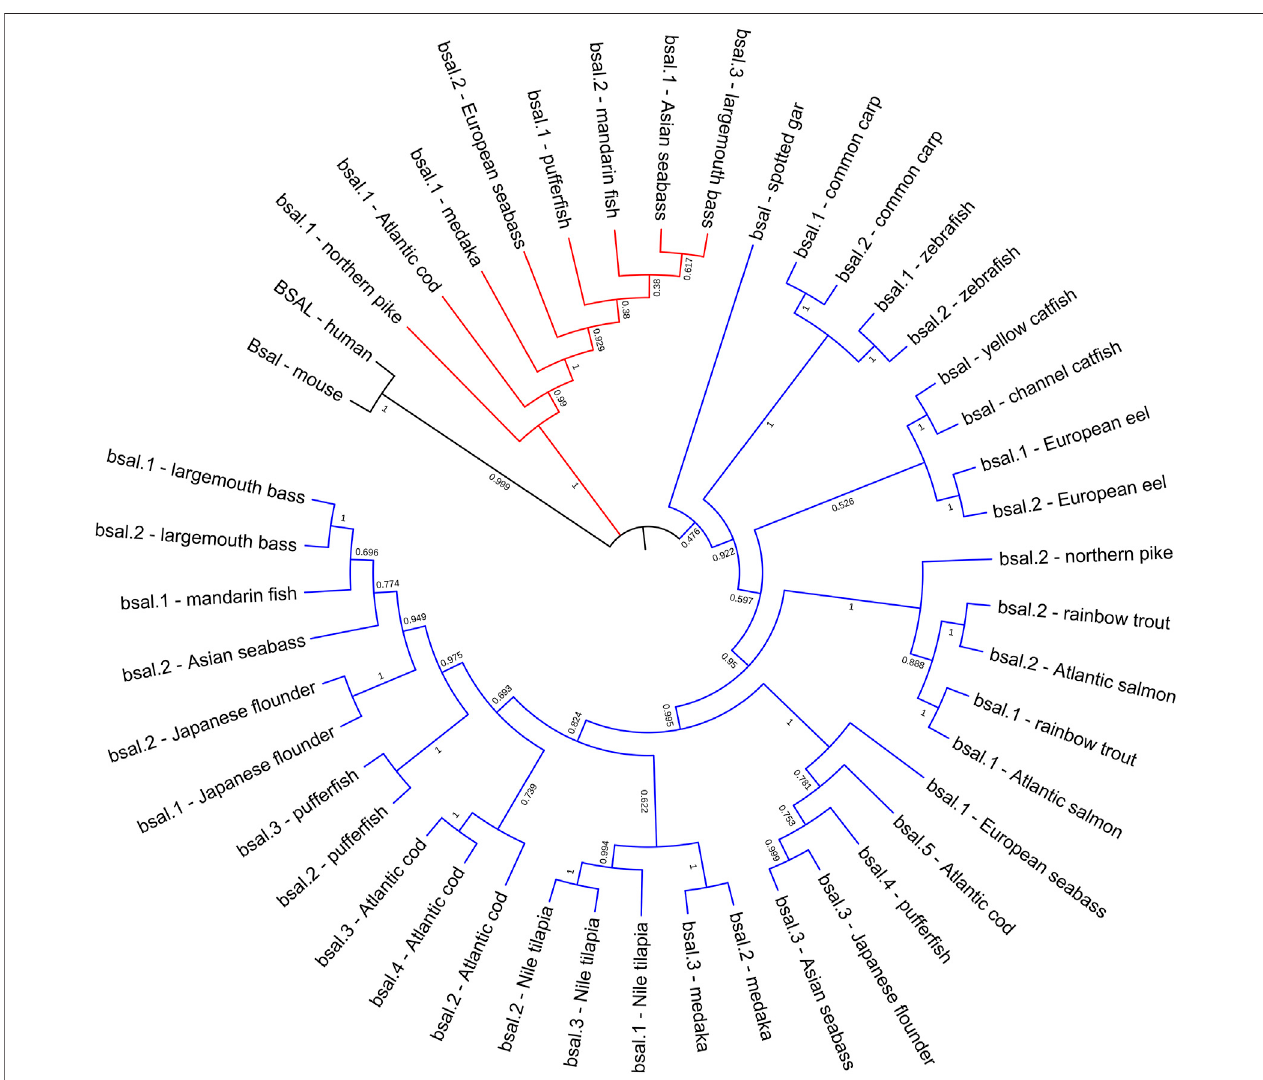
FIGURE4| Phylogeneticrelationship ofbilesalt-activatedlipase genesin mammals and fi sheswithbasedon theML method. Thebootstrap test (1000replicates) scores are shown with numbers. The black line represents the group of BSAL genes in mammals. The fi sh bsal genes whose neighborhood gene was conserved were shown with the blue line, the other bsal copies were shown with the red line.